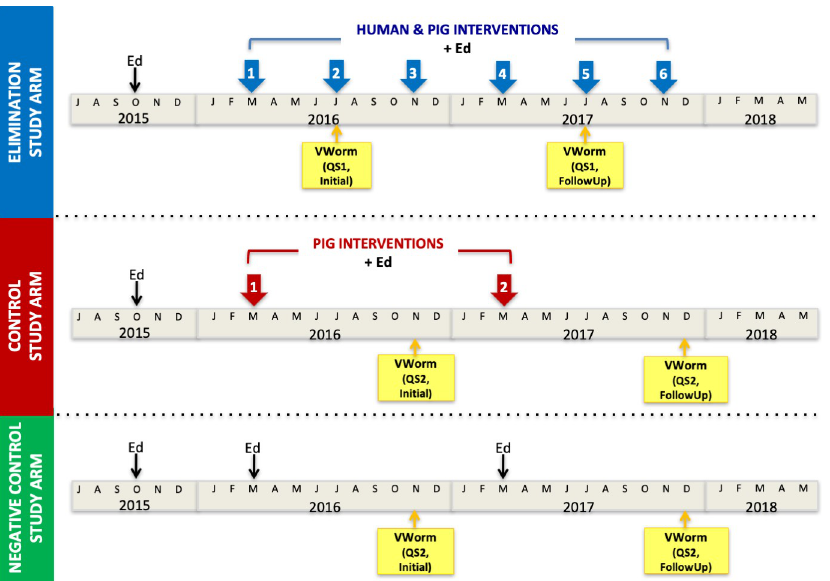
Fig 1. Timeline of CYSTISTOP’s interventional and educational activities in the three study arms. Village-based educational sessions (Ed) were conducted in all three study arms at baseline, then every four months in the elimination study arm, and annually in the control study arm in conjuction with intervention activities. Education alone was conducted annually in the negative control study arm. Initial Vicious Worm workshops (VWorm) were conducted in one primary school in each of the three study arms in 2016, and follow-up sessions were conducted one year later. Assessment questionnaire 1 (QS1) was used in the elimination study arm workshops, while the revised QS2 was used in the control and negative control study arms.